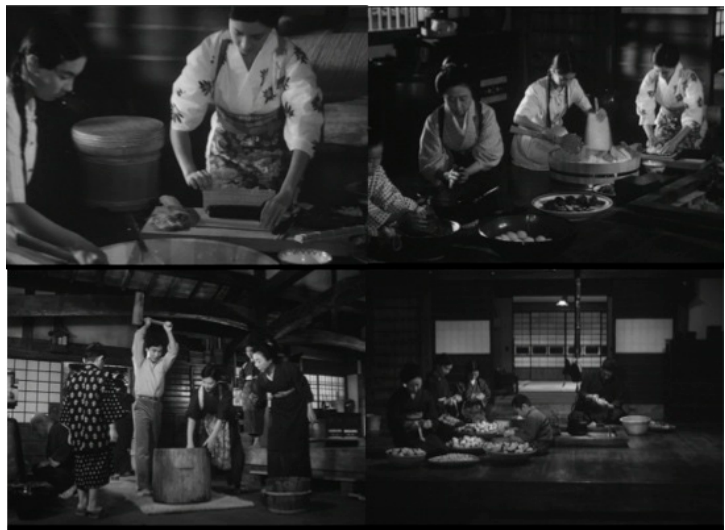
Figure 2. Mother (Shind ō Kaneto, 1963) .